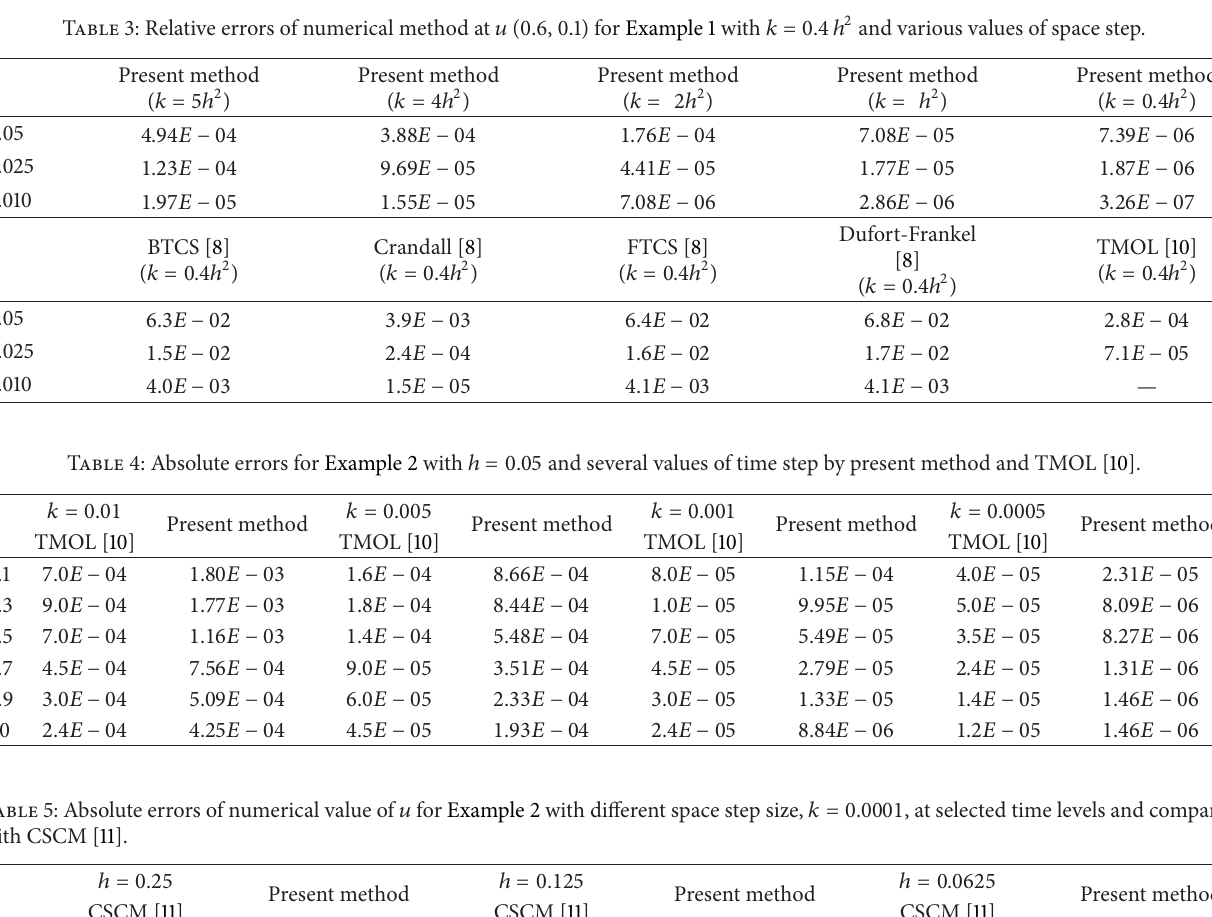
Table 3: Relative errors of numerical method at 𝑢 (0.6, 0.1) for Example 1 with 𝑘 = 0.4 ℎ 2 and various values of space step.